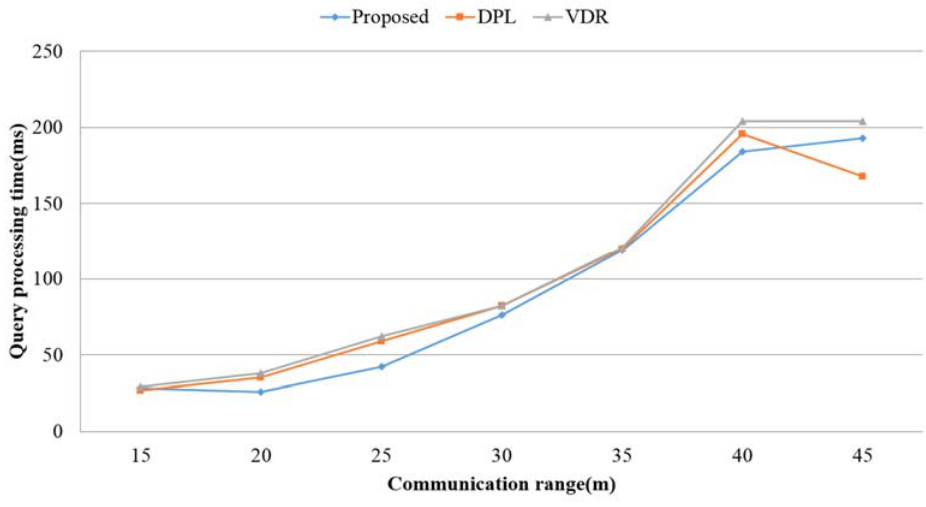
Figure 16. Query-processing time according to communication Figure 16. Query ‐ processing time according to communication range.